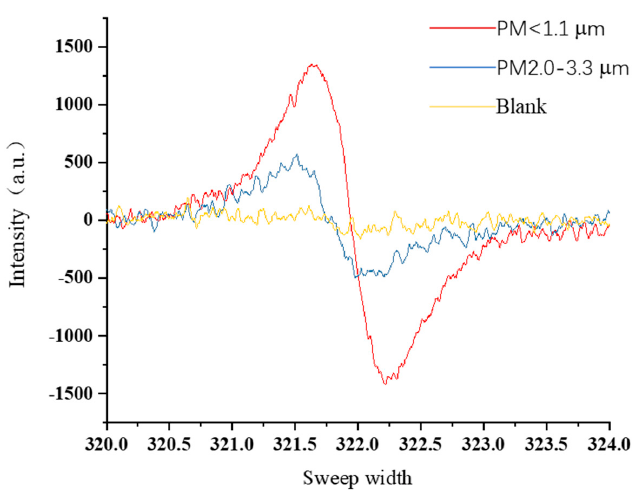
Figure 6. Free radicals generated from coal combustion particles. Free radical intensity varied with different particle sizes. Fine particles (PM < 1.1 μ m) could generate stronger free radicals (present study, not published).